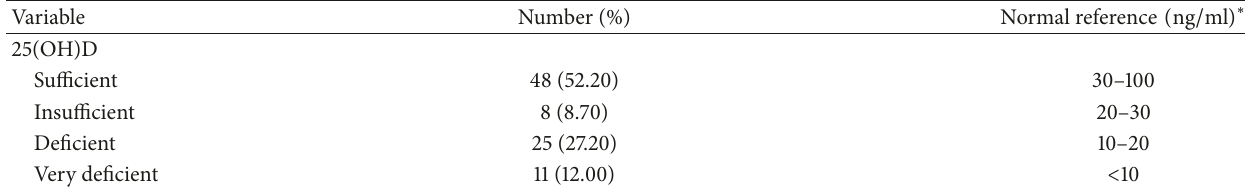
Table 3: Distribution of the matched levels of 25(OH)D for the studied healthy